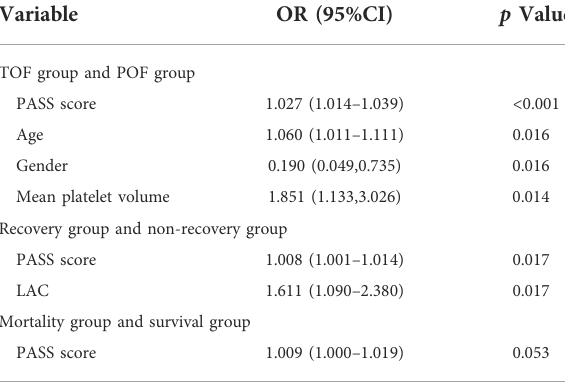
TABLE 6 Multivariate analysis of potential clinical predictors of AP